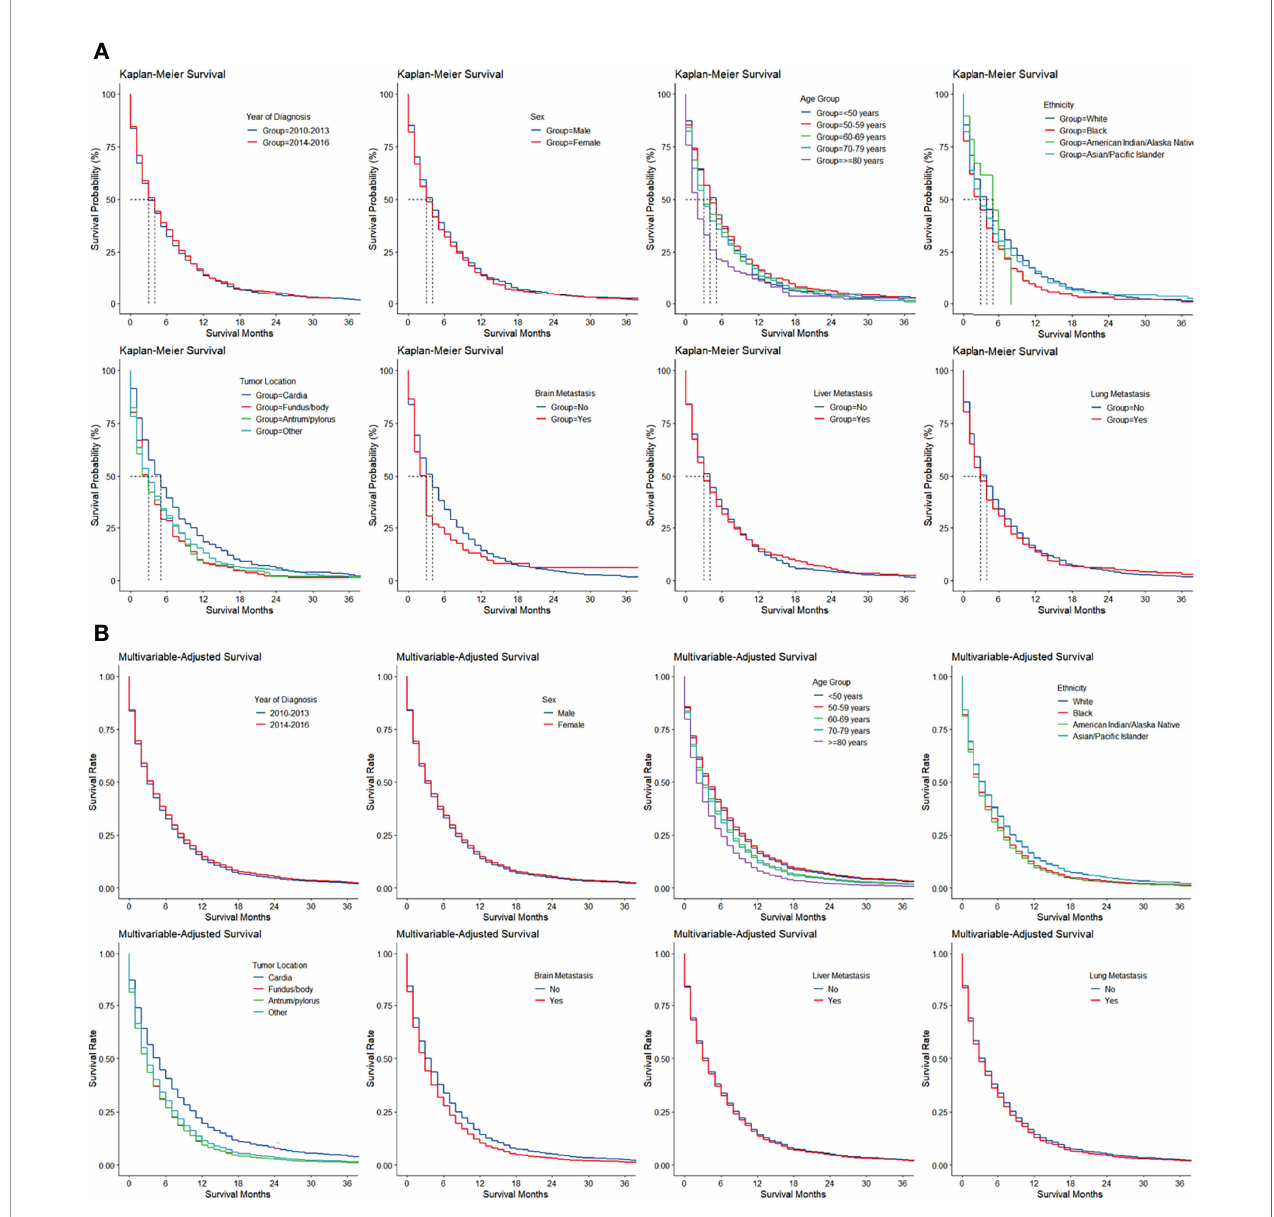
FIGURE 2 | (A) Kaplan – Meier and (B) multivariable-adjusted survival by patient and tumor factors in gastric adenocarcinoma with bone